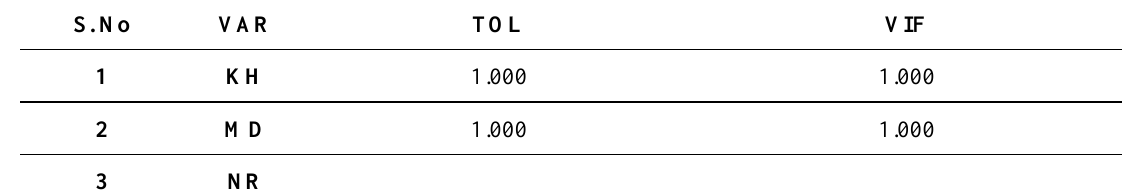
Table.1. TOL and VIF Test of